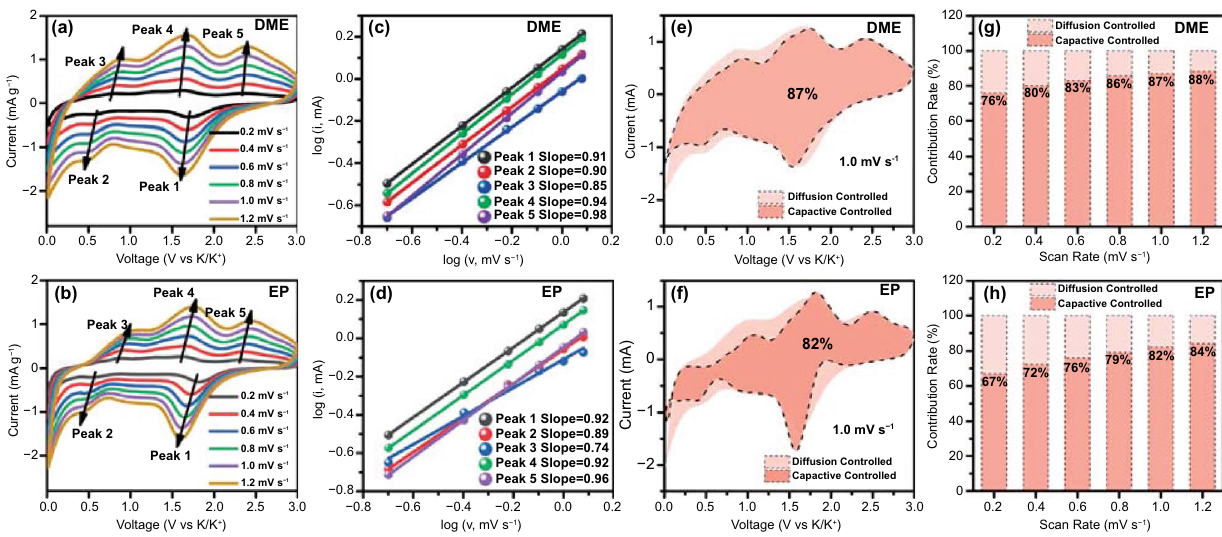
Fig. 6 CV curves of FeSe 2 @RGO electrode using a DME-based and b EP-based electrolyte in different scan rates. The relationship between log ( i ) and log ( v ) of FeSe 2 @RGO electrode using c DME-based and d EP-based electrolytes. The capacitive contribution area of FeSe 2 @RGO elec- trode using e DME-based and f EP-based electrolytes at 1.0 mV s −1 . Capacitive contribution ratios across different scan rates of FeSe 2 @RGO electrode using g DME-based and h EP-based